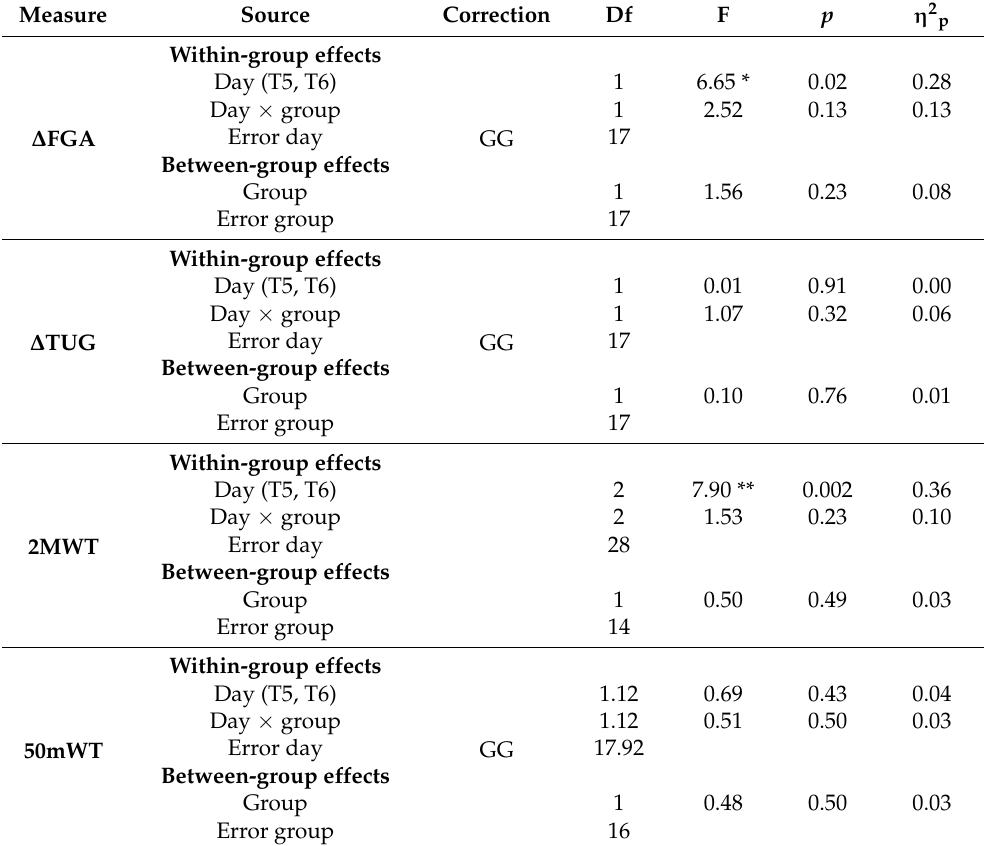
Table 3. Two-way mixed-model ANOVA examining the changes from baseline in FGA score ( ∆ FGA) and time spent performing the TUG ( ∆ TUG) as well as performance on the 50mWT and 2MWT with the between-subject factor group (PwMS real vs. PwMS sham ) and the within factor day (T0, T5,